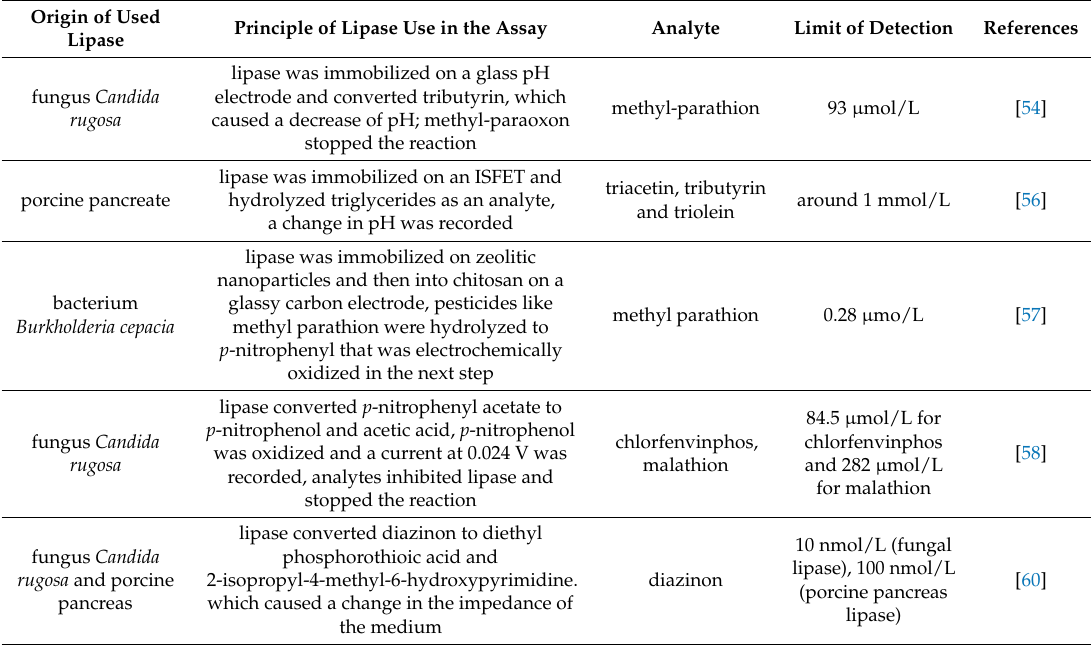
Table 3. The overview of lipase-based electrochemical assays.